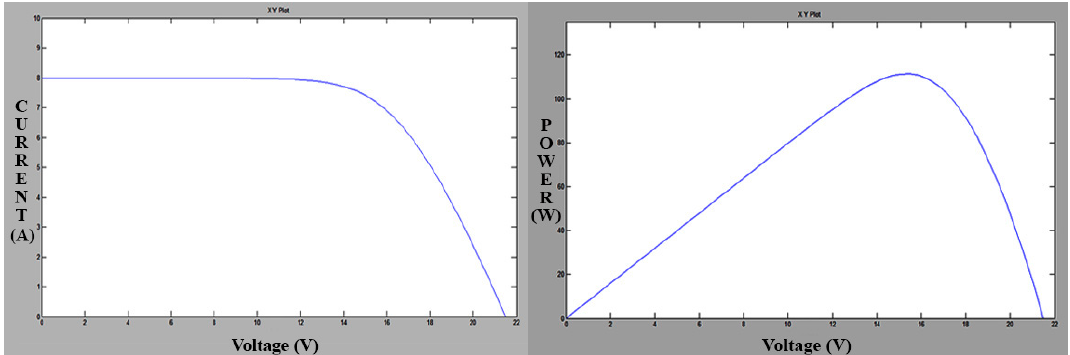
Figure 3. I-V characteristics and P-V characteristics.